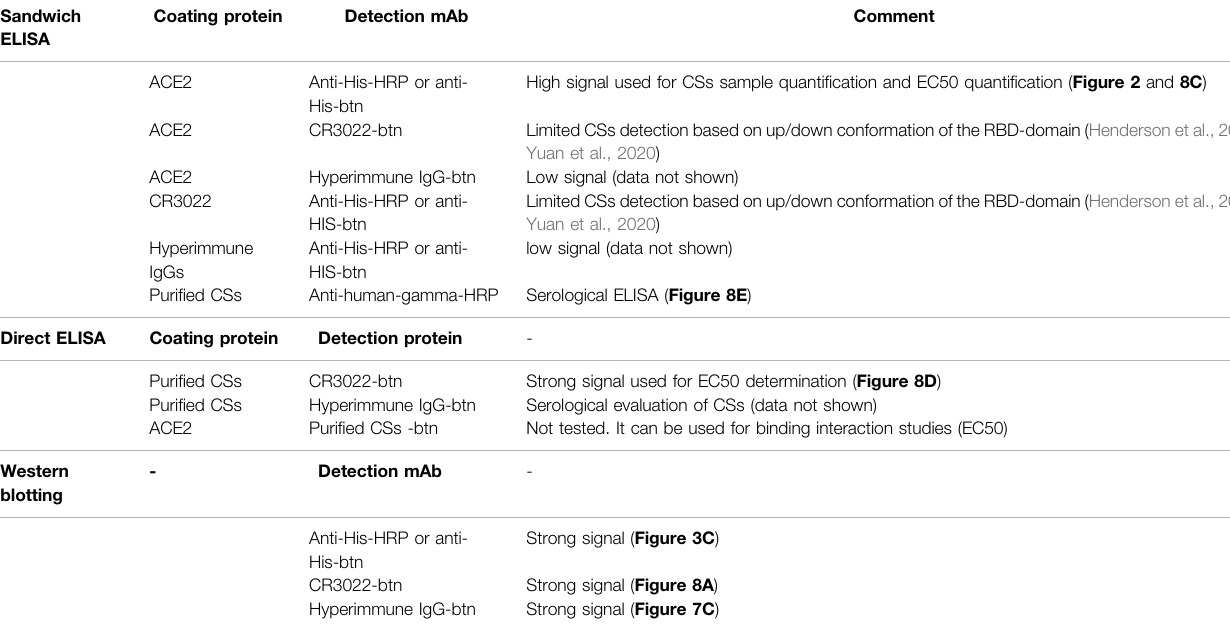
TABLE1| ELISAandWesternblottingrepertoireforanalyticalscreeningofchimericspikesoluble(CSs) subclonesandtoverifythequalityandfunctionalityoftheexpressed CSs protein. Sandwich